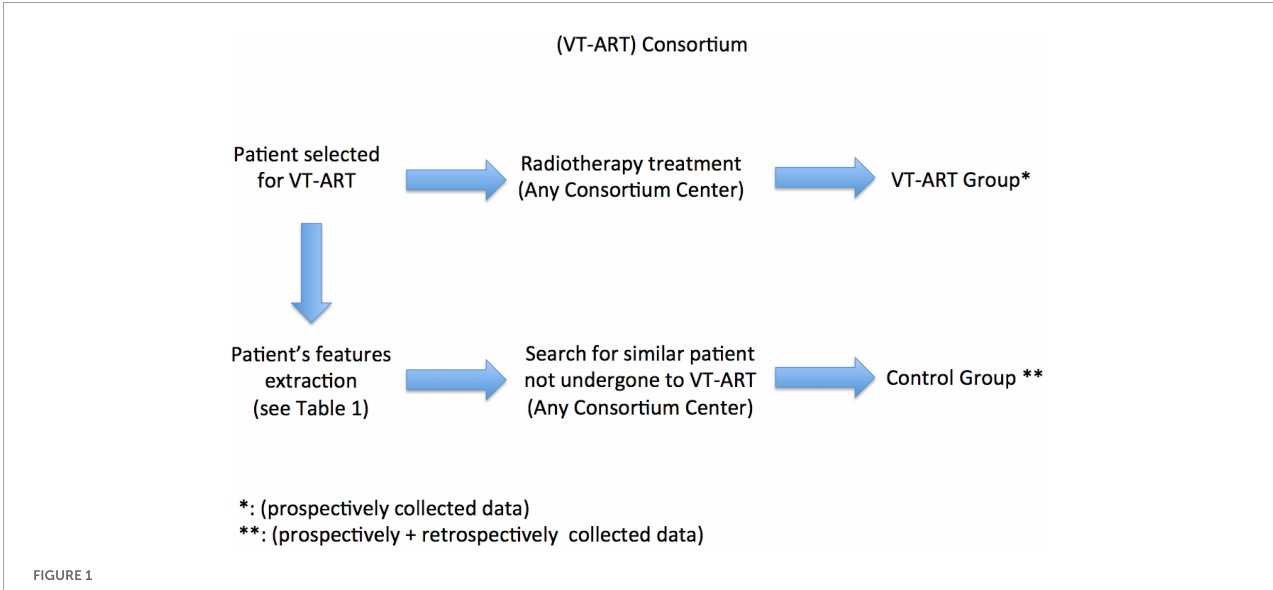
FIGURE1 Overview of the VT-ART